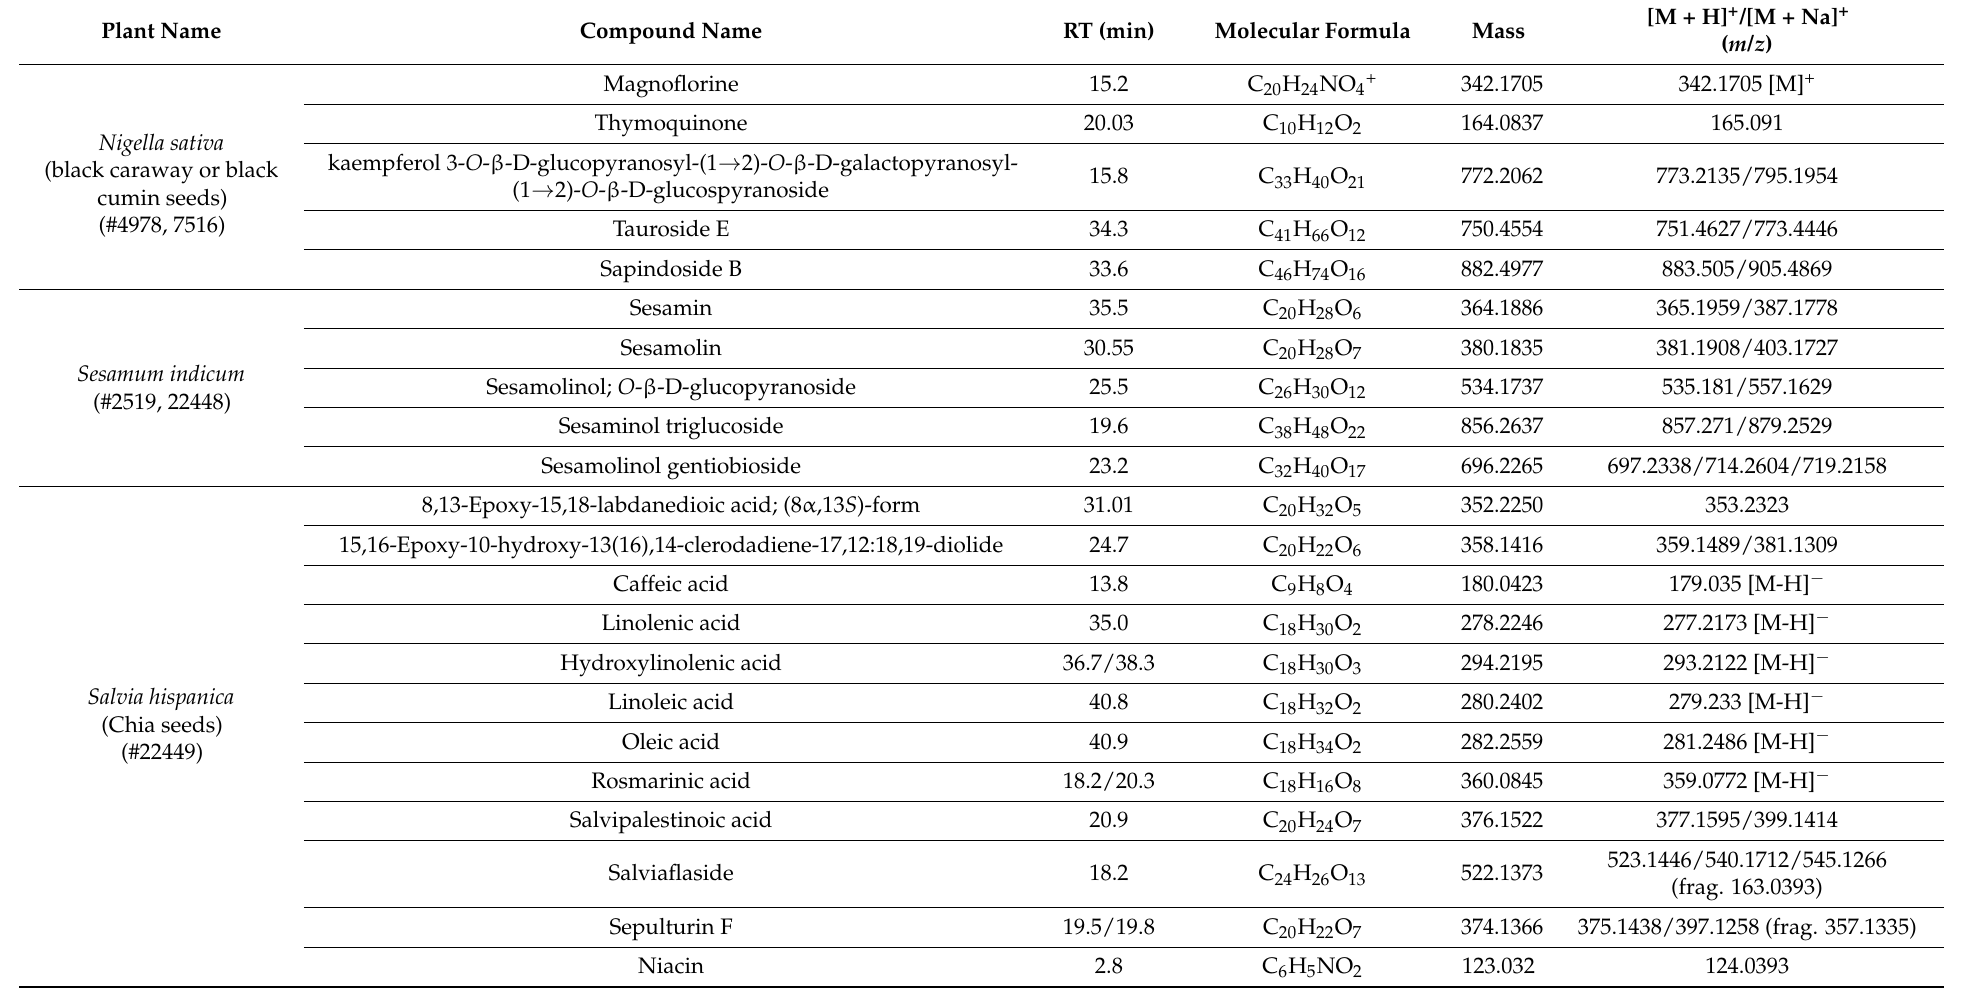
Table 5. Adulterants derived from plants in poppy seed adulteration: plant name, compound name, retention time in minutes, molecular formula, mass, m/z , and major ion fragments for adulterants detected using